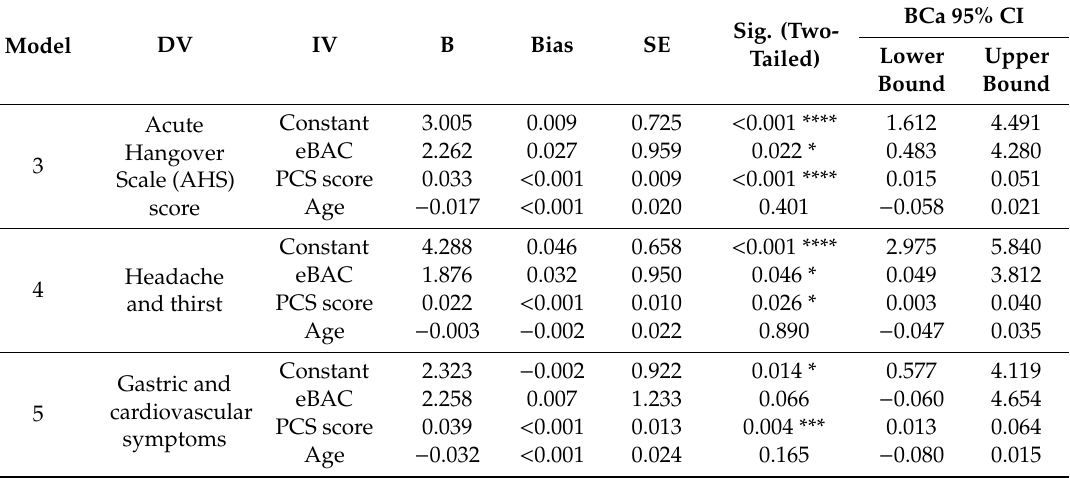
Table 7. Summary of bootstrapped regression model coe ffi